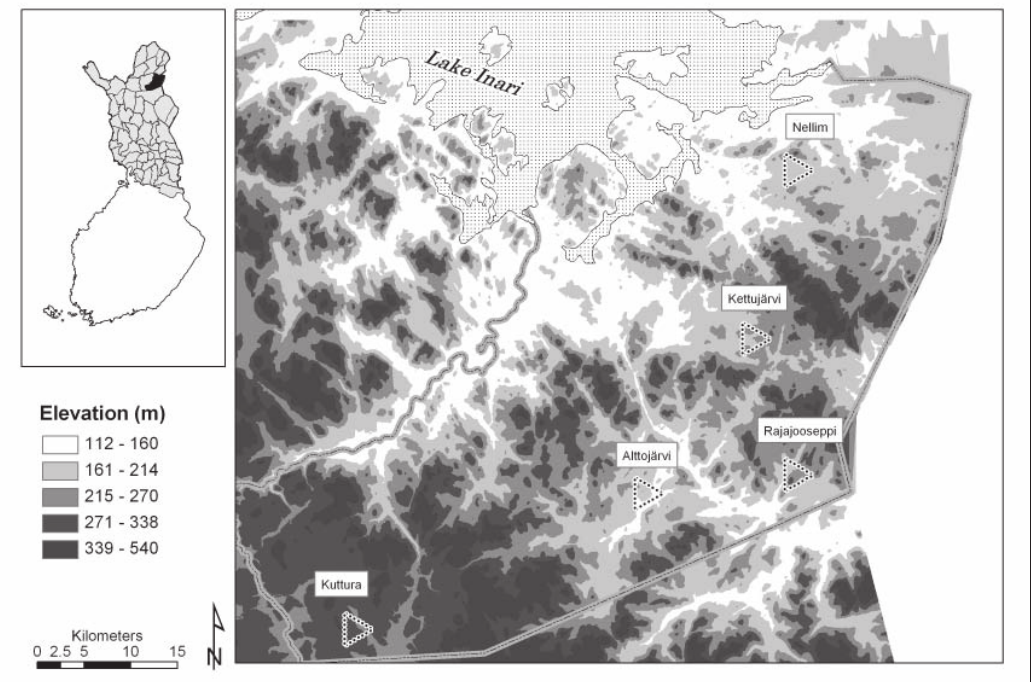
Fig. 1. Location and elevation classes of the Ivalo reindeer herding district and sites with snow measurement